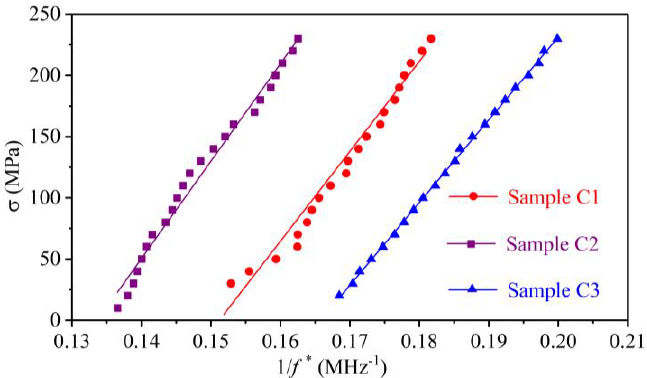
Figure 12. Fitting lines between the stress and the inverse of the characteristic frequency extracted from the derivation of the phase difference curves.